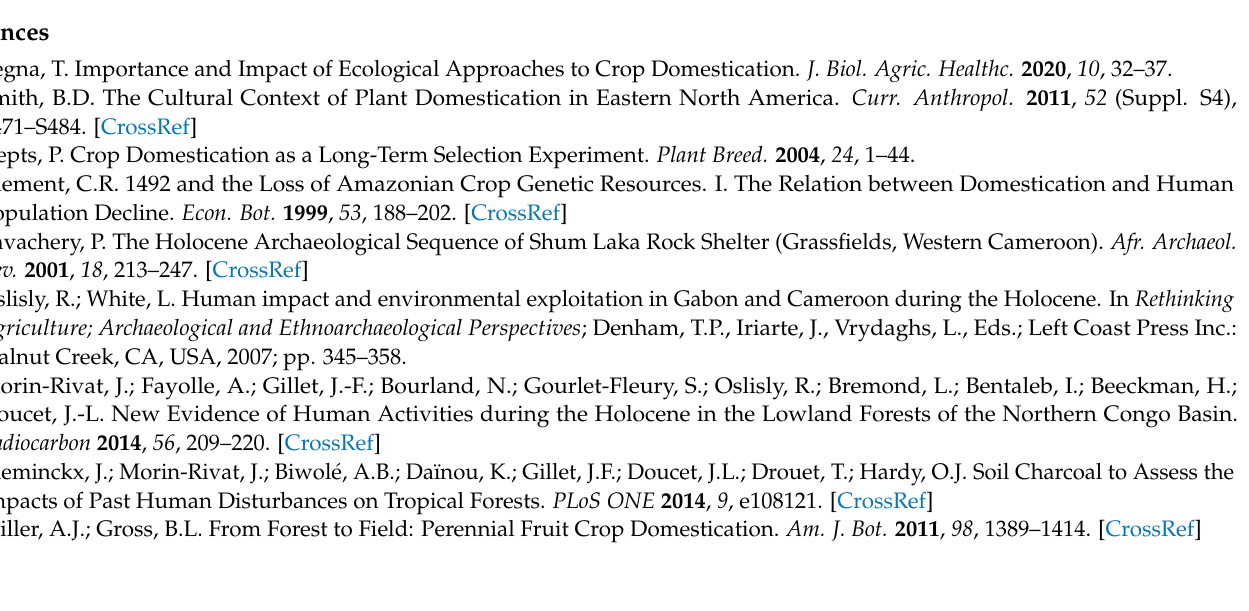
(F) morphology of a cultivated flower, (G) morphology of the ovary and stamin of a cultivated female flower, (H) morphology of the ovary and stamin of a wild flower (magnification: 2 × ), Figure S2: (A) Discrimination of wild and cultivated individuals along the two axes according to gender, population. (B) Correlation of variables to the formation of axes 1 and 2. (C) Separation of individuals along axis 1 according to sites. (D) Separation of populations according to the height of individuals, Figure S3: Distribution of the number of cotyledon lobes between wild and culti- vated seeds, Figure S4: (A) Discrimination of wild and cultivated fruits from the FAMD according to axes 1 and 2. (B) Correlation and contribution of variables to the formation of axes 1 and 2, Figure S5: (A) Segregation of individuals along the two axes according to individual status and sites. (B) Correlation of variables to the formation of axes 1 and 2. Figure S6: Descriptors developed by Kengue (1990) for the flowers, Figure S7: Descriptors of fruits and seeds morphometric characteris- tics of D. edulis (Ndindeng et al., 2008), Table S1: Morphometric characteristics of fruits and seeds between sites, Table S2: Seed characteristics used for the germination test, Table S3: Morphometric characteristics of wild and cultivated fruits’ pulp of